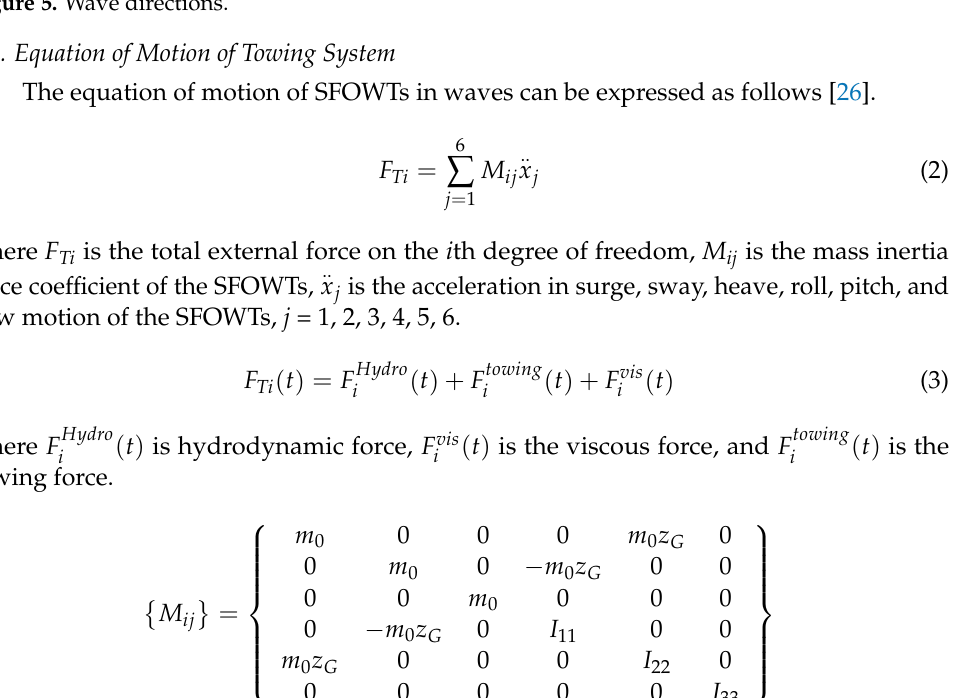
Figure 5. Wave directions.